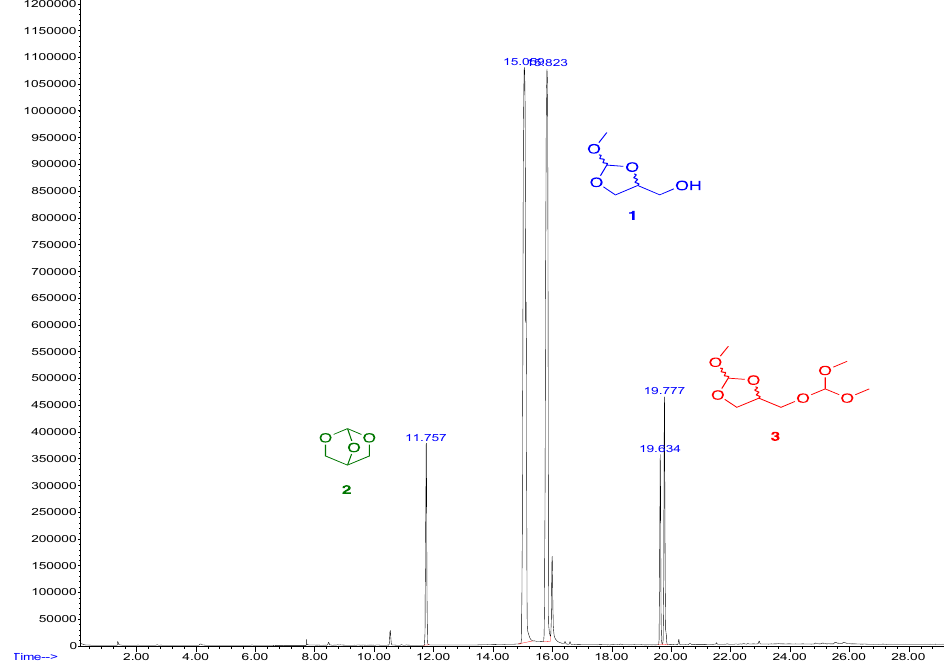
Figure 4. Gaschromatogram of the reaction between HC(OMe) 3 and Gly with Q = 1, 90 °C, 1 h.